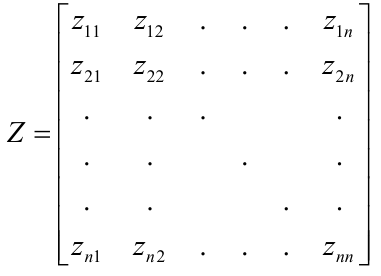
Fig. 1. nxn direct relation matrix